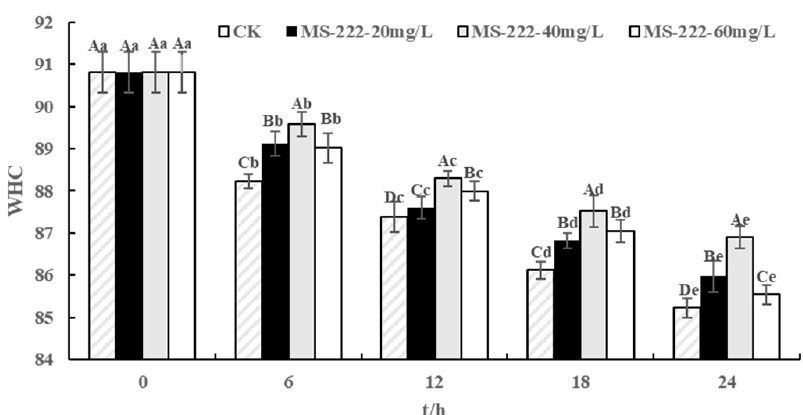
Figure 2. Changes in the water holding capacity (WHC) of turbot flesh during simulated transport. Different capital letters indicate significant differences in the average between groups. Different lowercase letters indicate significant differences in the average value within each group ( p < 0.05). CK, control group.